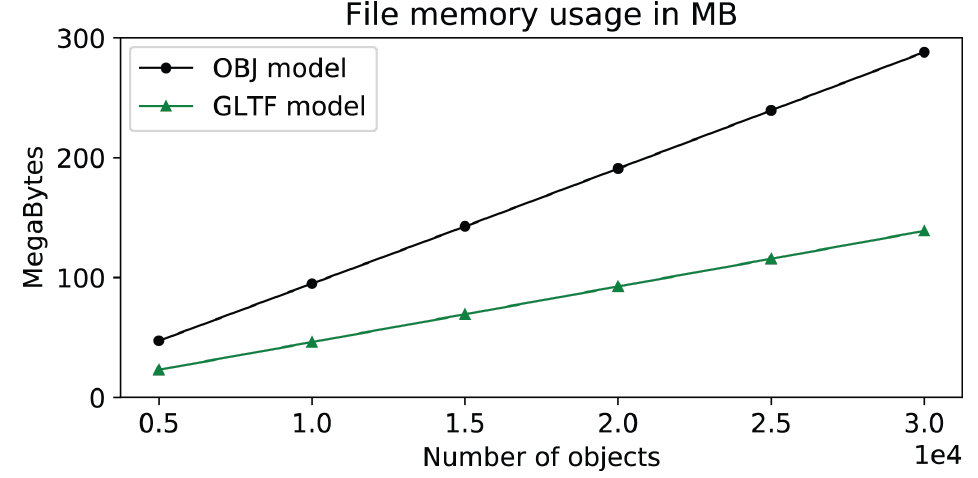
Figure 8. Size comparison of 3D model file using GLTF and OBJ